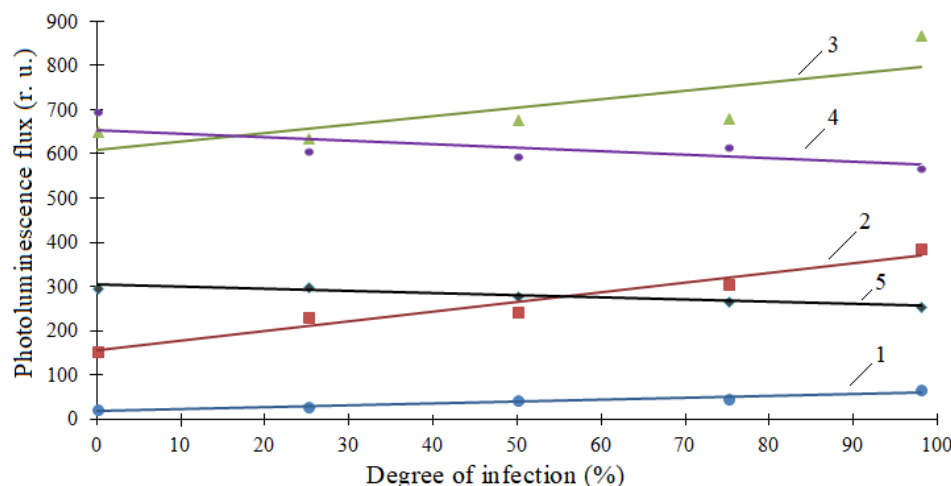
Figure 3. Dependences of photoluminescence fluxes on the degree of contamination of barley seeds Φ λ ( β ): 1—at λ e = 232 nm; 2—at λ e = 362 nm; 3—at λ e = 424 nm; 4—at λ e = 485 nm; 5—at λ e = 528 nm.